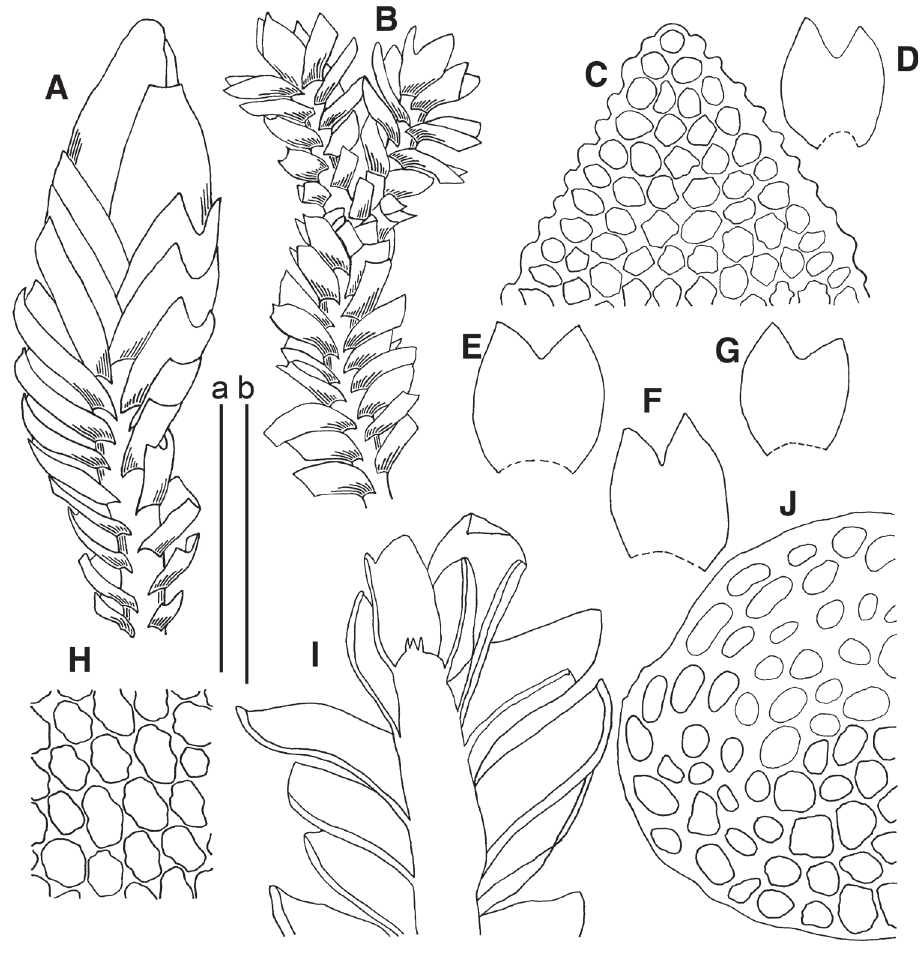
Figure 10. Gymnomitrion parvitextum (Steph.) Mamontov, Konstant. et Potemkin A female plant (frag- ment) B male plant (fragment) C leaf lobe apex D–G leaves H midleaf cells I gynoecium longitudinal sec- tion J stem cross section (fragment). Scale bars: a 1 mm ( A, B, D–G ); a 500 μm ( I ); b 100 μm ( C, H, J ). All from Choi 8475